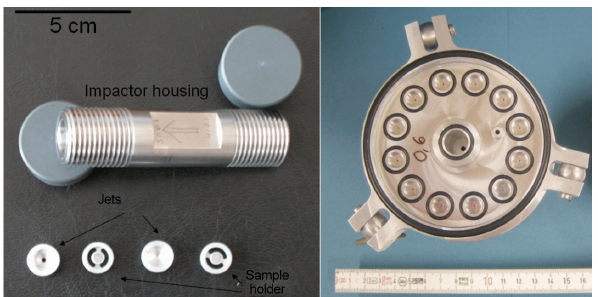
Figure 1. Left: single two-stage impactor used during RECON- CILE. Right: multi-impactor system (allows 12 samples per flight) with purging system used during ESSenCe. Table 1. Aerosol samples with corresponding flight date, potential temperature (K) and the vortex indicator based on dynamic tracer measurements and CTM modeling for RECONCILE and ESSenCe (data from Weigel et al., 2014). Aerosol Flight Potential Vortex Flight sample